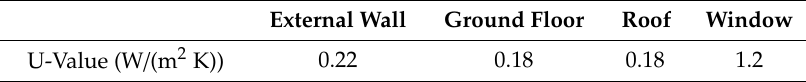
Figure 5. Layout of the second floor (Source: Norgeshus). Table 1. Building envelope components.